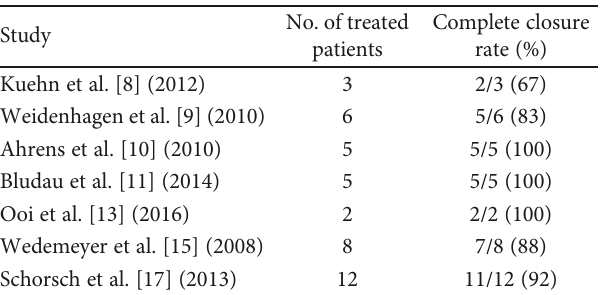
Table 4: E-VAC therapy clinical success rates reported in previous case